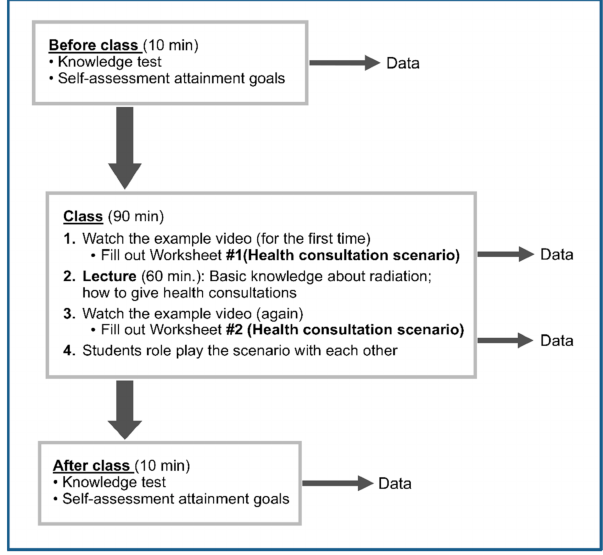
Figure 1. Flow and teaching tools used in the